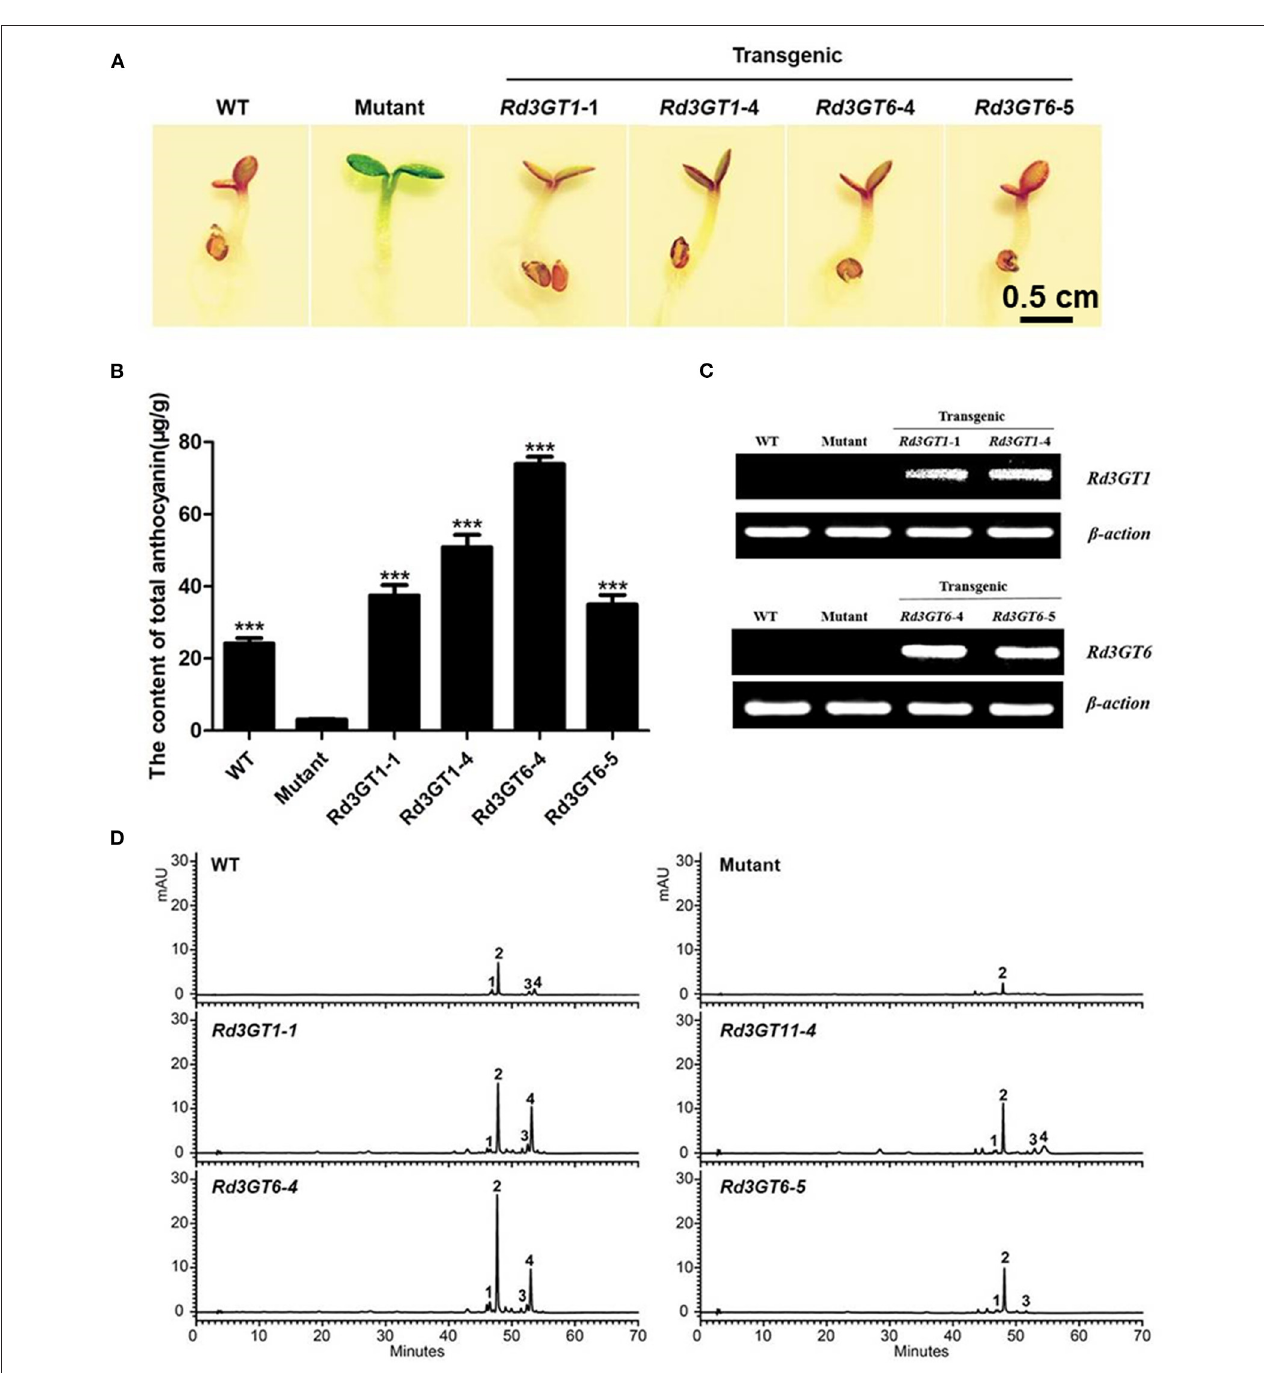
FIGURE 5 | Complementation of the pigmentation of UGT78D2 mutant seedlings with Rd3GT1 and Rd3GT6 . (A) Phenotypes of wild-type, mutant, and transgenic Arabidopsis seedlings. (B) Contents of anthocyanins in Arabidopsis seedlings. (C) Expressional analysis of Rd3GT1 and Rd3GT6 by reverse transcription polymerase chain reaction. (D) HPLC analyses of anthocyanins in Arabidopsis seedlings. Data correspond to means of three biological replicates. Asterisks indicate significant differences between means of mutant and wild-type as well as transgenic plants calculated by Student’s t -test (*** p < 0.001).